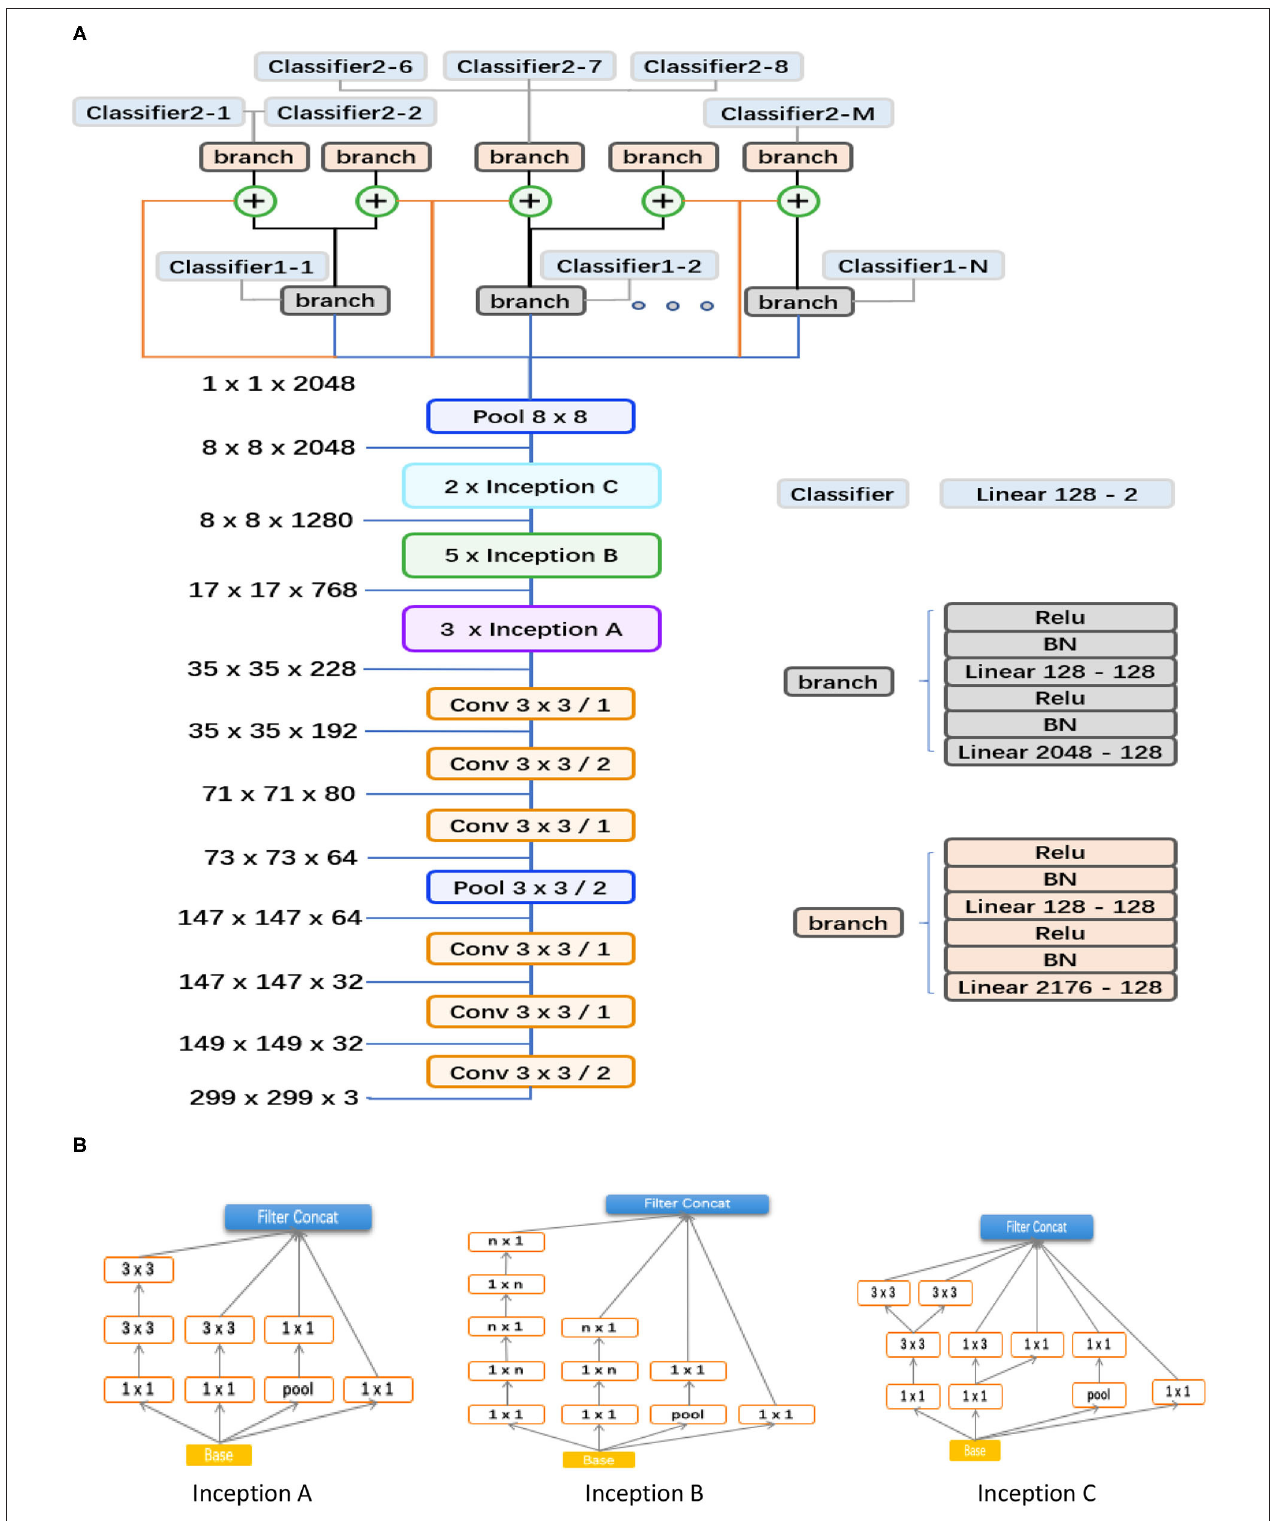
FIGURE 3 | Abstraction of the proposed hierarchical deep learning framework. (A) The proposed network architecture based on the feature network of Inception v3 (Conv 3 × 3/2 indicates that a 3 × 3 convolution kernel was used and stride = 2). The corresponding sizes of the input and output for each module are also shown.